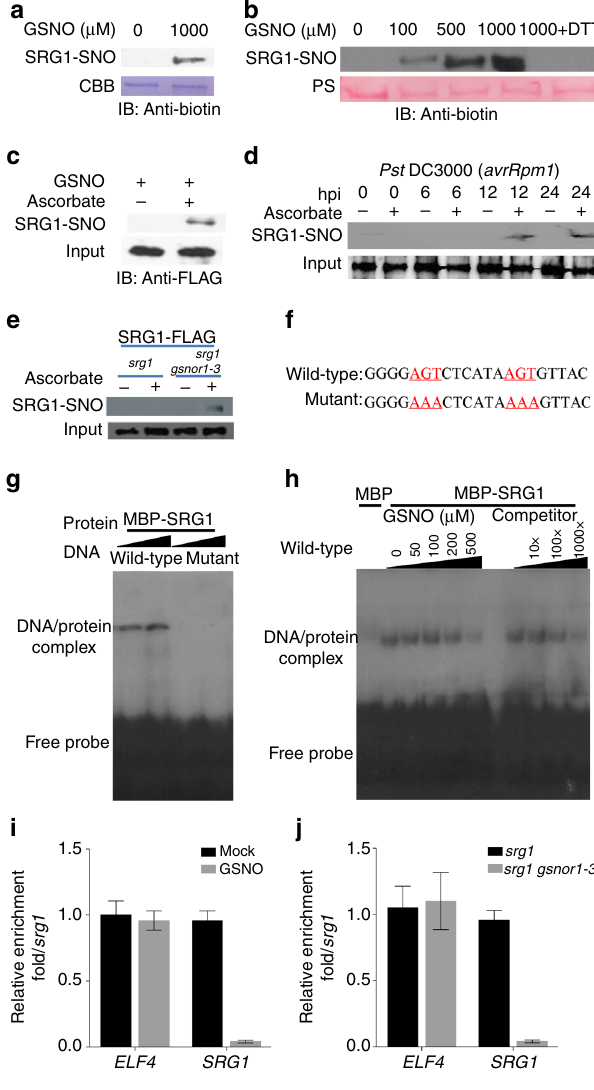
Fig. 3 Regulation of SRG1 DNA-binding activity by S -nitrosylation. a S -nitrosoglutathione (GSNO)-induced S -nitrosylation of SRG1 in vitro. Recombinant SRG1 was subjected to the biotin-switch assay and the resulting protein was interrogated by western blot analysis utilising an anti- biotin antibody. CBB, Coomassie Brilliant Blue protein stain. b Recombinant MBP-SRG1 was incubated with the stated concentrations of GSNO and subsequently subjected to the biotin-switch assay. PS, Ponceau S stain. c Total protein extracts from srg1 plants expressing SRG1-FLAG were subjected to the biotin-switch assay after exposure to 1 mM GSNO